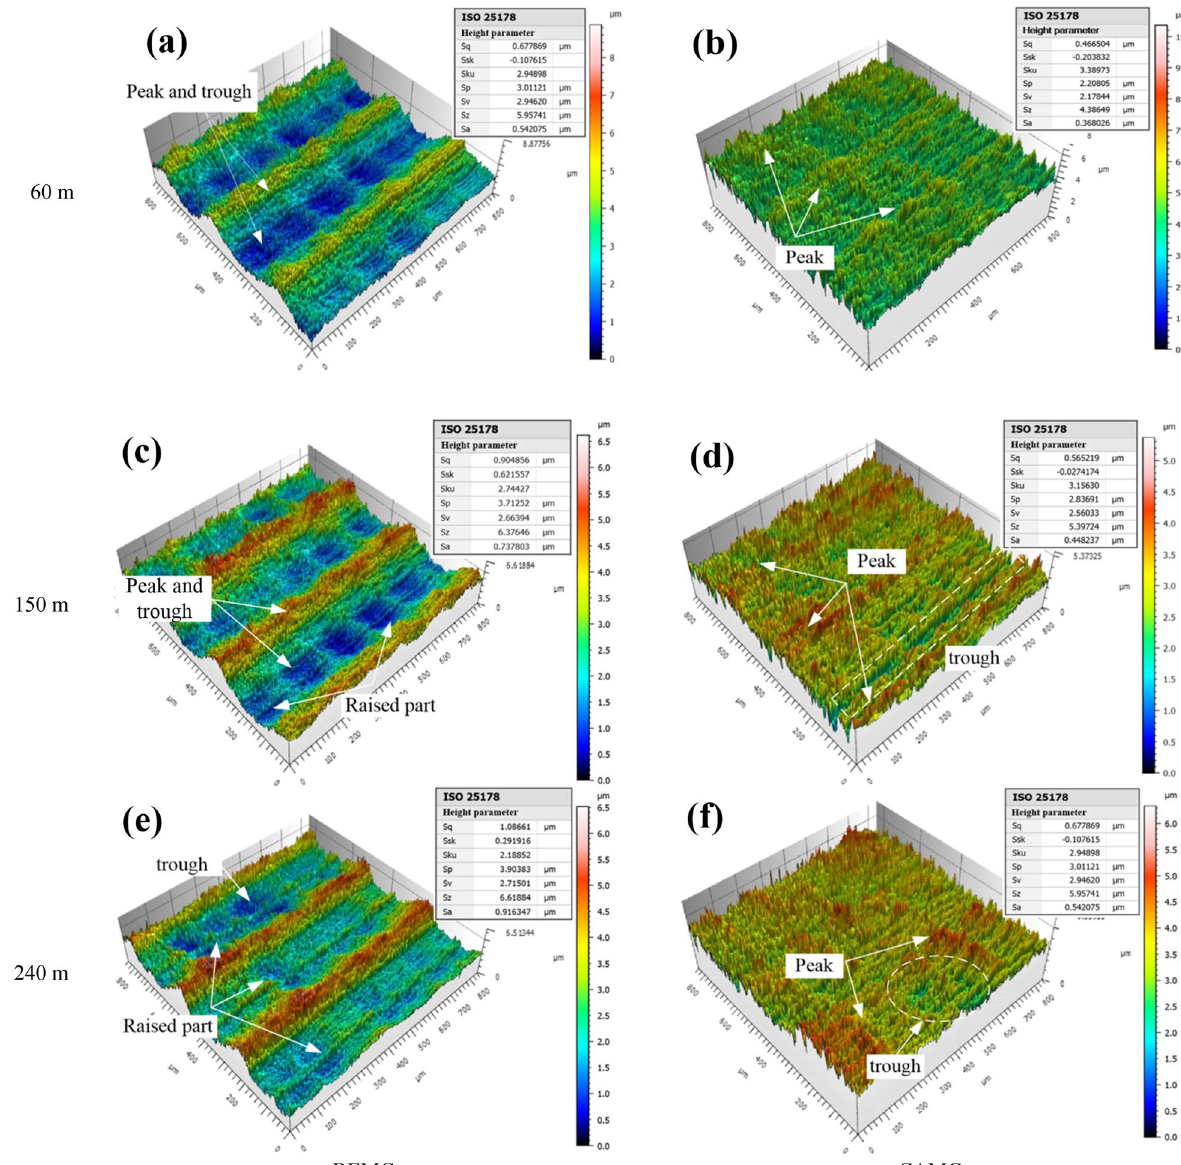
Figure 6 Comparison of the machined surface morphology at different